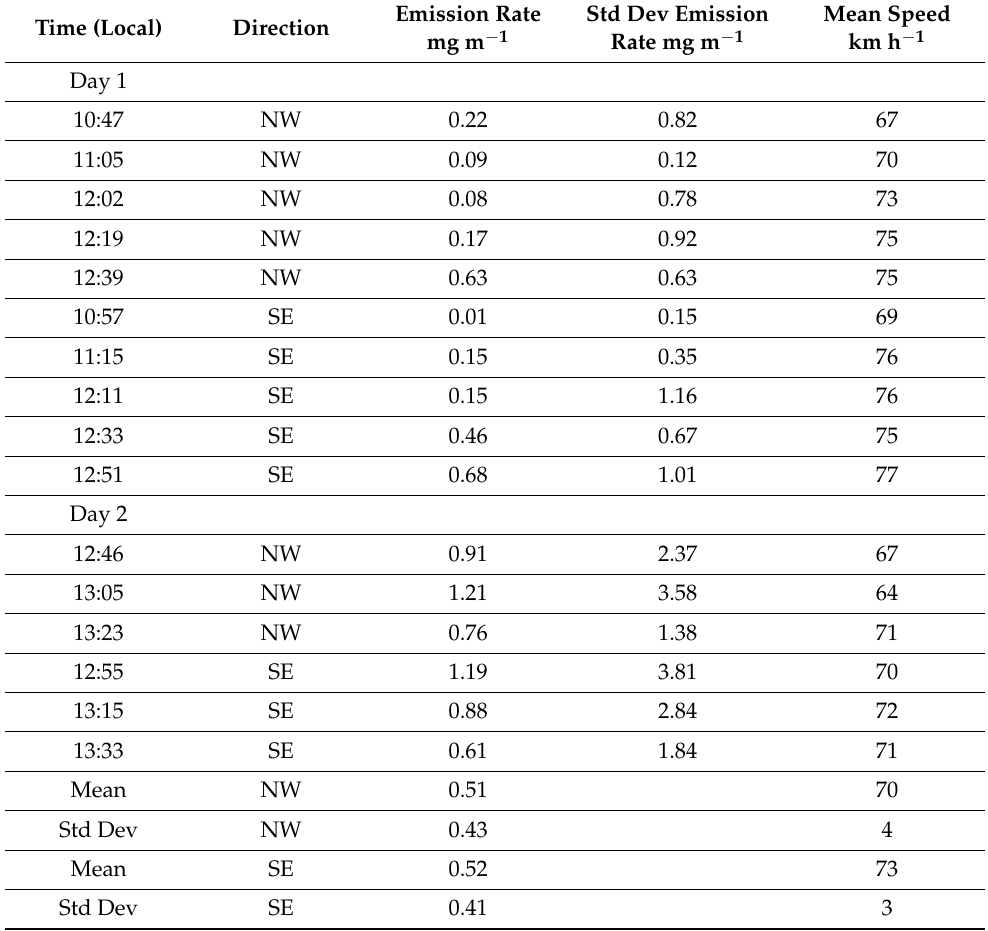
Table 3. SCAMPER PM 10 pass-averaged emission rate data for the Ford Expedition for each direction of each test run.